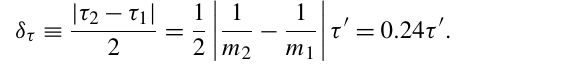
A measure of OT change during air mass change from m 1 to m 2 can be defined